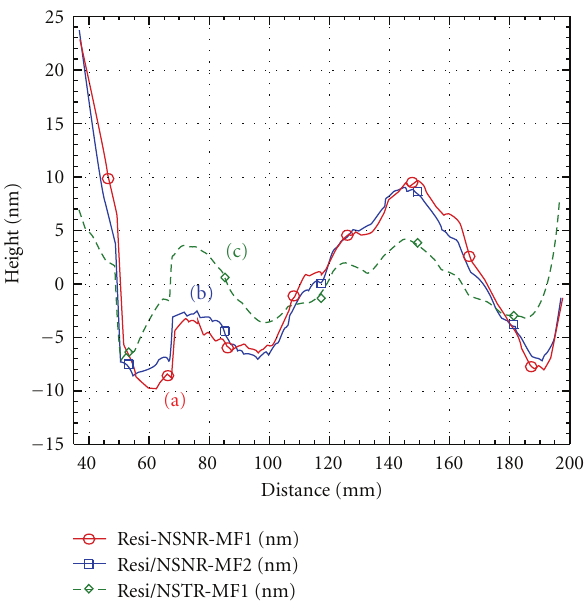
Figure 10: Comparison tests between tilted and nontilted reference methods. (a) Independent nontilted reference and nontilted sam- ple. (b) Nontilted reference of second OH and nontilted sample. (c) Tilted reference and nontilted